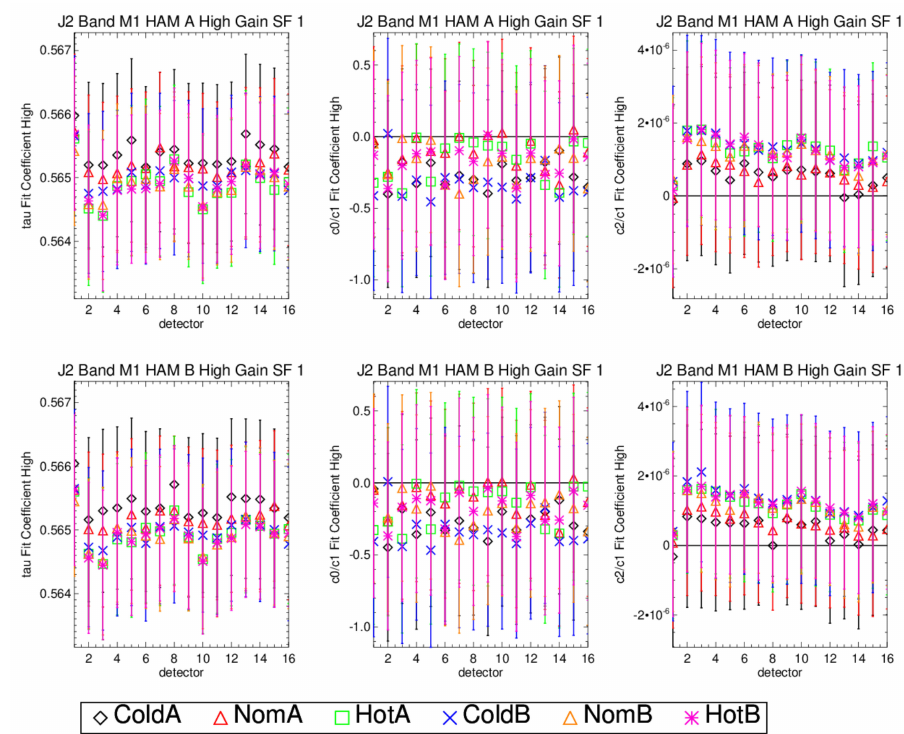
Figure 8. Band M1 high gain fit coefficients for all detectors (x-axis) and TVAC/electronics configura- tions (colors and symbols). The columns are tau, c 0